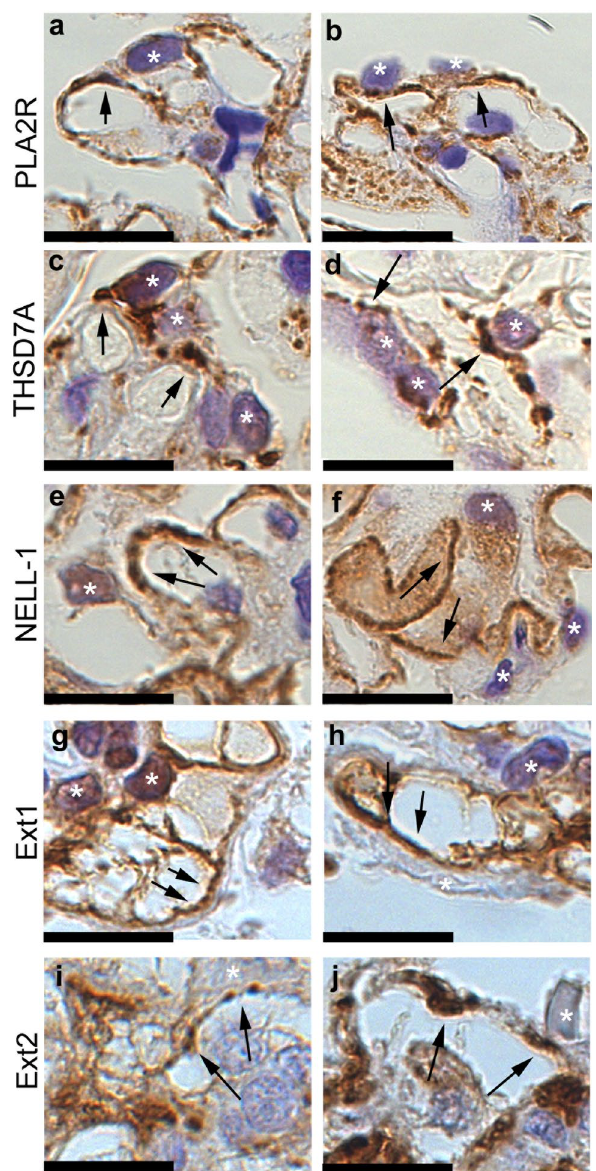
Figure 4. Immunohistochemical analysis for case of Phospholipase A2 receptor (PLA2R)-, Thrombospondin type-1 domain-containing 7A (THSD7A)-, Neural epidermal growth factor-like 1 protein (NELL-1)-, Exostosin (Ext) 1- and Ext2-associated membranous nephropathy with high magnification. Photographs of immunostaining of PLA2R ( a , b ), THSD7A ( c , d ), NELL-1 ( e , f ), Ext1( g , h ) and Ext2 ( i , j ) with high magnification. The localization of enhanced antigens was shown with arrows. Asterisks; podocytes. Scar bar 12.5